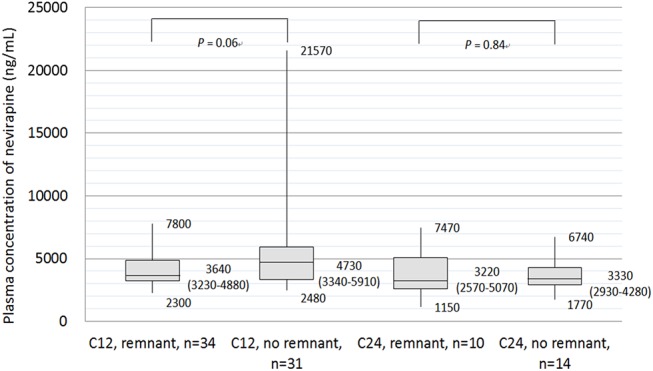
Plasma concentrations of nevirapine 12 hours (C12) and 24 hours (C24) following the previous dosing of nevirapine extended-release in patients noticing and those not noticing tablet remnants in stools.(Numbers in box plots indicate the median, interquartile range, maximum and minimum values).